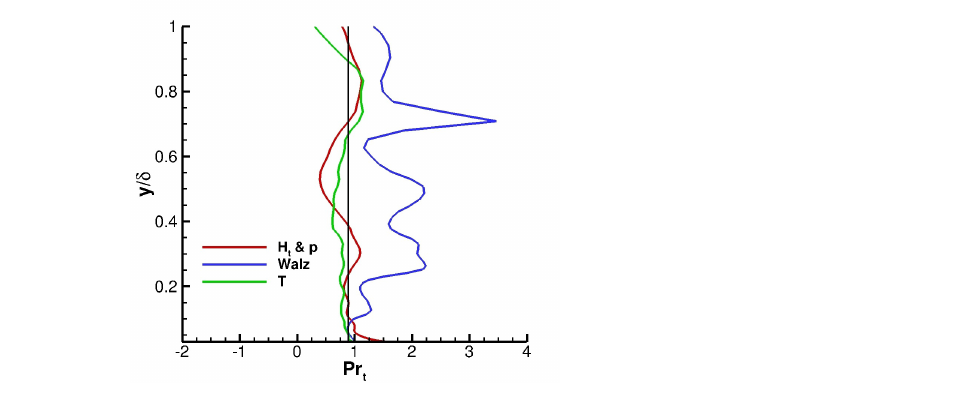
Figure 5. Effectof recycling-rescaling method on turbulent Prandtl number for Condition No. 2.